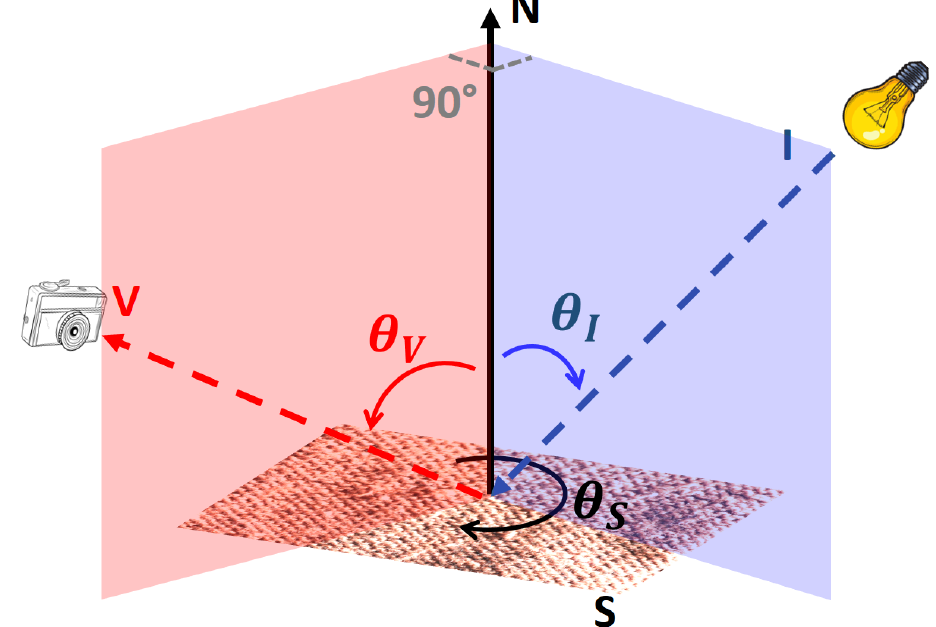
Figure 10. Schematic diagram of the image acquisition setup. In our experiments, the plane defined by vectors N and I was set perpendicular to the plane defined by vectors N and V. The example shown in Figure 11 illustrates how such a change can modify the material appearance for a given material